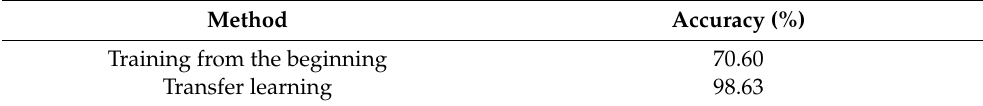
Table 2. Transfer learning